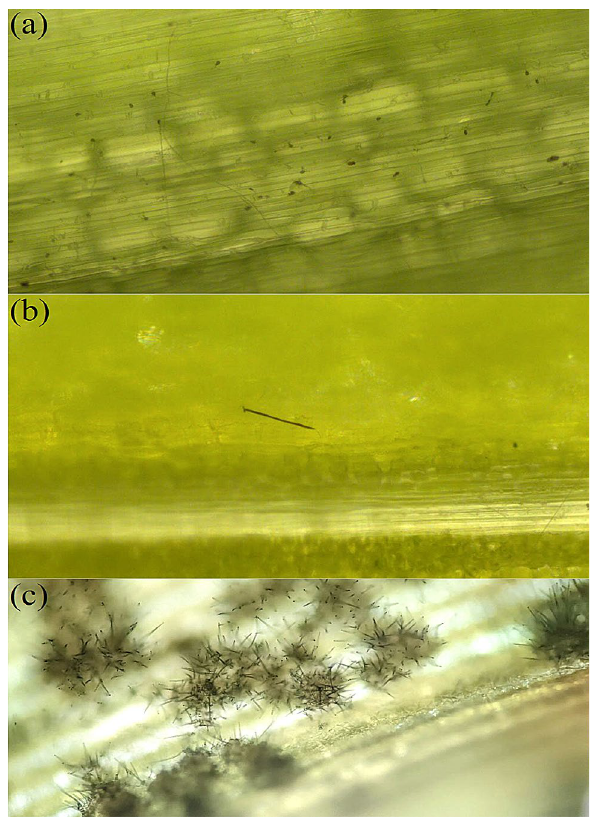
Figure 1. Acervuli formation was confirmed on leaf segments of Sorghum seedlings response to FSP53 at 96 h post-inoculation. ( a ) Visual representation of score 1. No visible infection was shown on a leaf segment of SC748-5 (resistant check) ( b ) Visual representation of score 2. Germ tube formation was confirmed on a leaf segment of SC748-5 ( c ) Acervuli formation was confirmed on a leaf segment of PI514300. Although not prevalent, FSP53 successfully formed acervuli on Senegalese seedlings. Note: The images of ( a ) and ( b ) were used for visual representation of score 1 and 2. The images are not associated with this study as it captured responses of leaf segments of SC748-5 at 8-leaf stage to FSP53 at 96 h post-inoculation from a previous unpublished